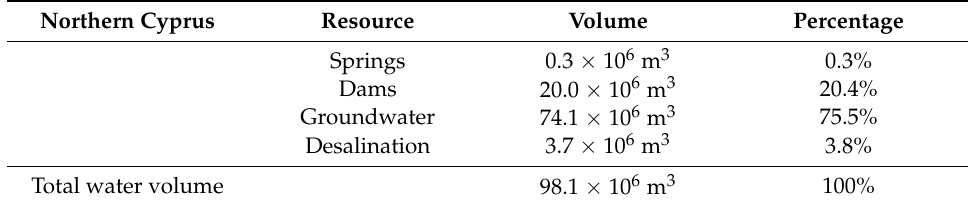
Figure 1. Geographical location of Northern Cyprus (NC). Table 1. Total available water at the resources of Northern Cyprus (NC) (Water Works Department, 2016).